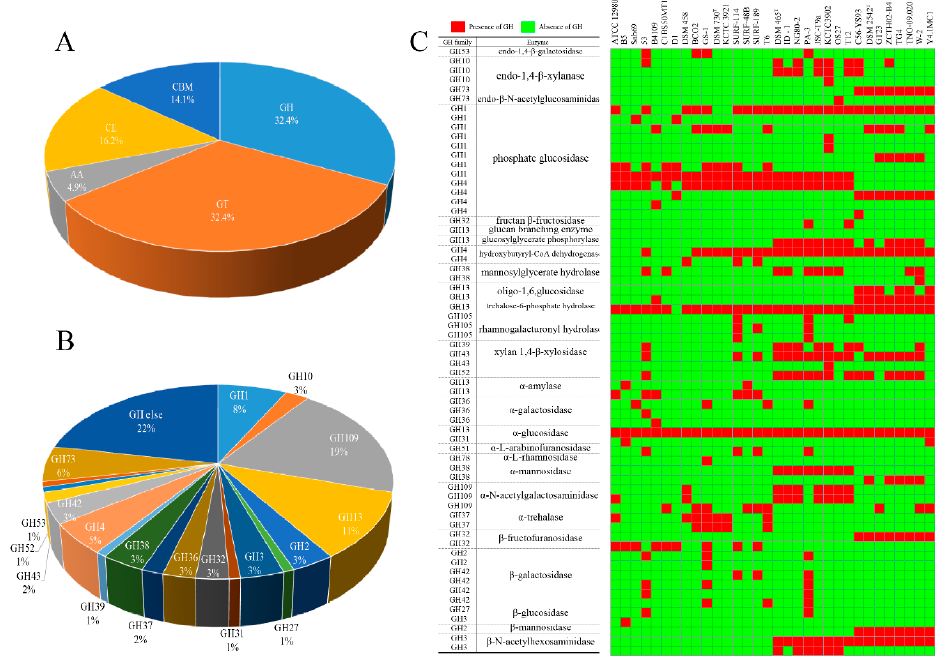
Figure 2. GH family distribution of all genomes. ( A ) Pie chart indicating the percentage of each category of CAZymes. ( B ) Pie chart indicating the percentage of each GH family. ( C ) Heatmap displaying the GH family members identified in all the